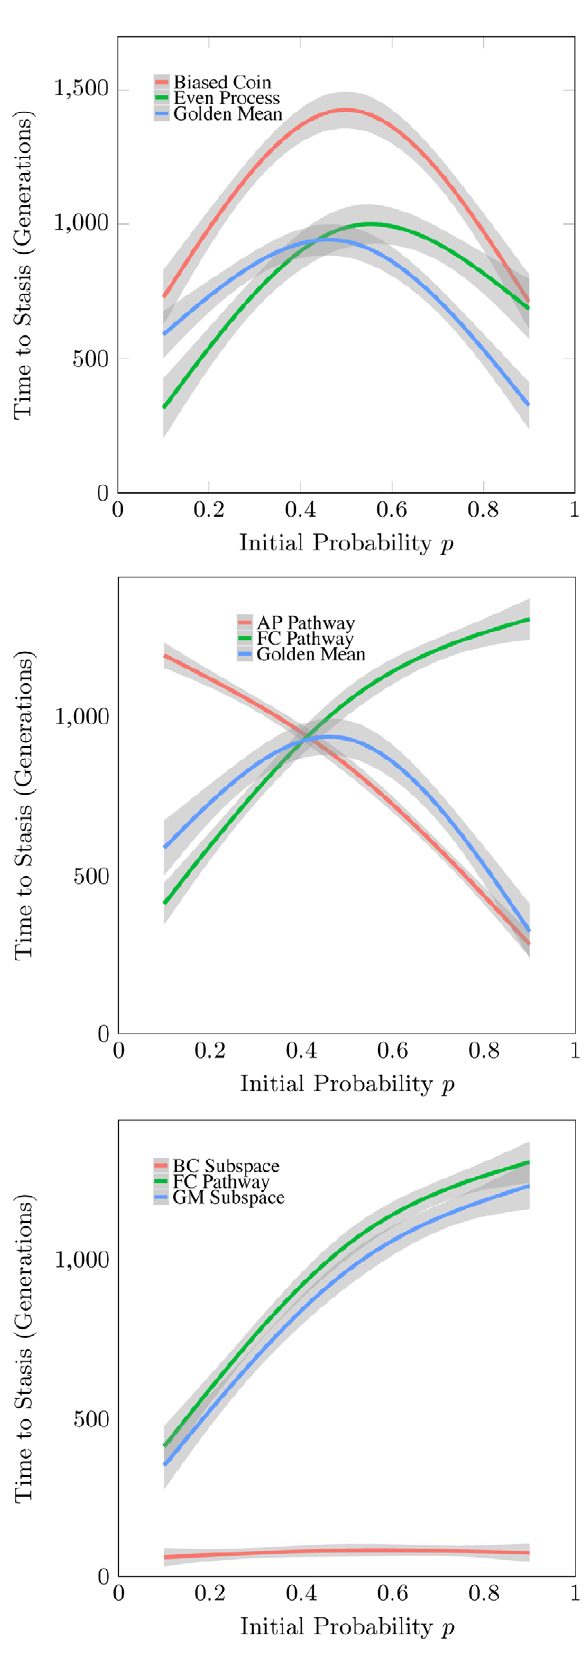
Figure 9. Top: Time to stasis of the Golden Mean, Even, and Biased Coin Processes. Middle : Stasis time of the Golden Mean Process as the weighted sum of stasis times for the Fixed Coin (FC) and Alternating Process (AP) pathways. Bottom : Stasis time of the FC pathway as the weighted sum of Golden Mean (GM) and Biased Coin (BC) subspace diffusion